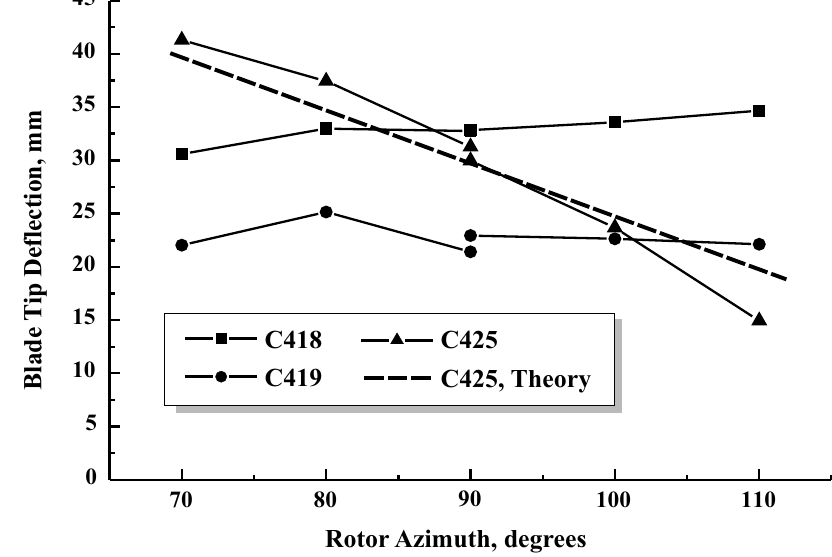
Fig. 17. Azimuth dependent mean blade tip deflection, r/R = 1 . 0 . Rotor shaft angle for C425 was set to − 3 degrees.